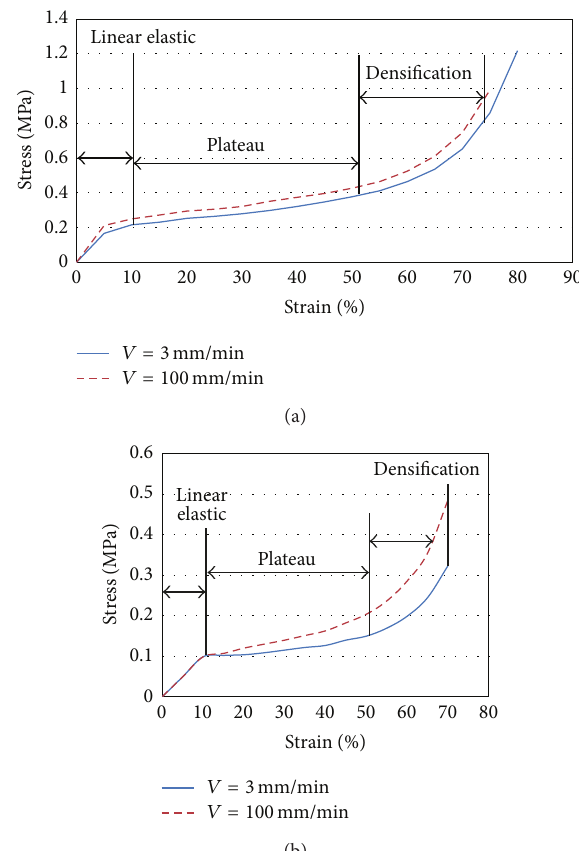
Figure 1: Stress-strain curves of crushable foams under quasi-static loadings in two rates: (a) EPP; (b) PUR.